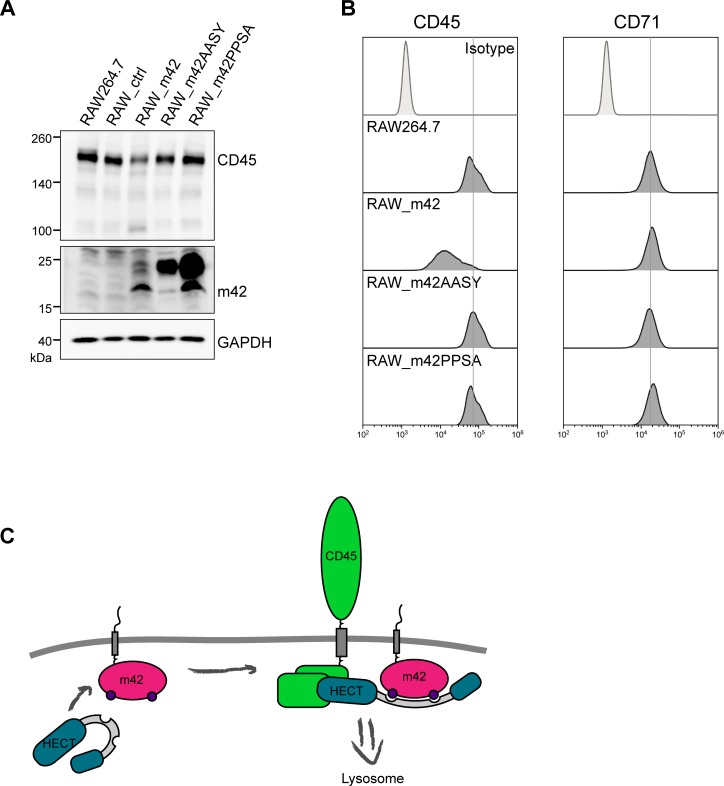
Unaffected CD45 expression in RAW264.7 cell lines expressing m42 variants with a mutated PPSY motif.(A) Analysis of CD45 and m42 levels in RAW264.7 cells stably expressing m42 variants with disrupted PPxY motif. Lysates of RAW264.7, RAW_ctrl, RAW_m42, RAW_m42AASY and RAW_m42PPSA cells were examined by immunoblotting for expression of CD45 and m42. GAPDH served as loading control. (B) CD45 and CD71 surface expression of the indicated cell line was measured by flow cytometry. (C) Proposed model for m42-mediated down-regulation of CD45. By interaction of m42 with Nedd4-like ubiquitin ligases of the HECT family, a conformational change is induced. The thereby activated ubiquitin ligase marks CD45 for internalization and subsequent degradation.